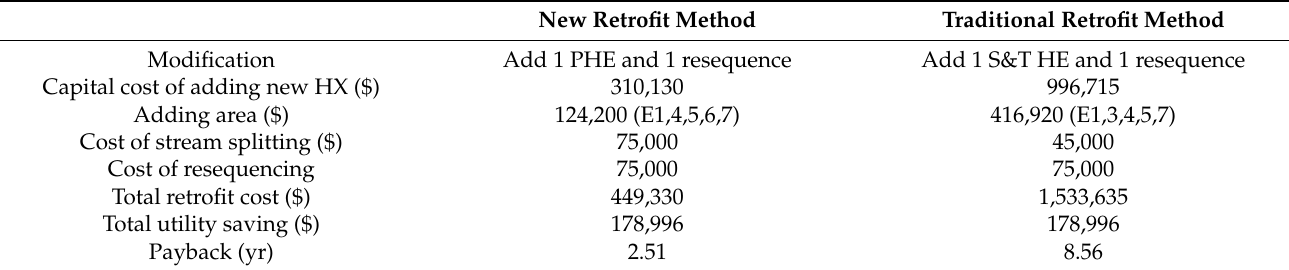
Figure 18. The best retrofit solution for case study 2 by adding S&THX. Table 5. The comparison results of two different